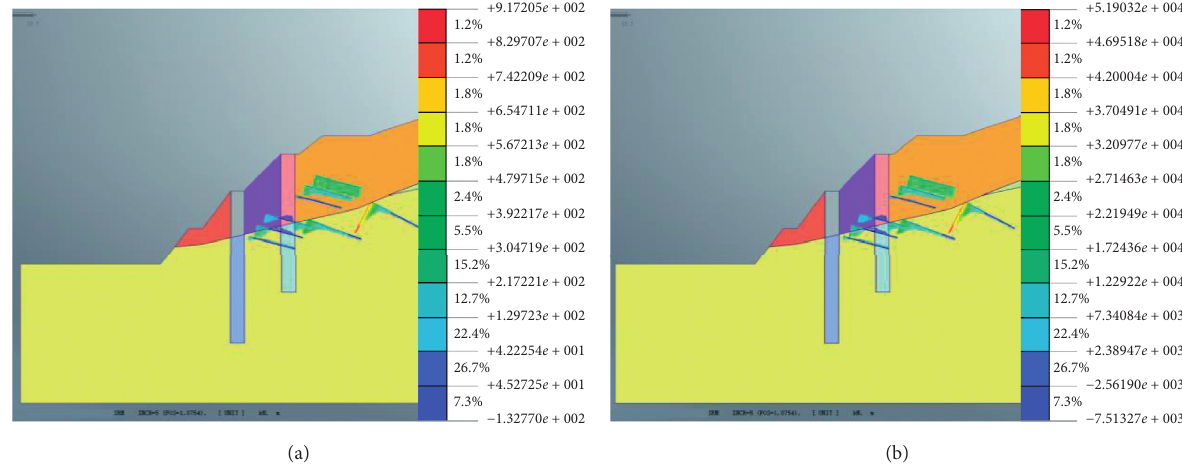
Figure 14: Cloud diagrams of prestressed anchor cable without considering steady-state seepage after construction of the secondary support: (a) axial force; (b) axial stress.